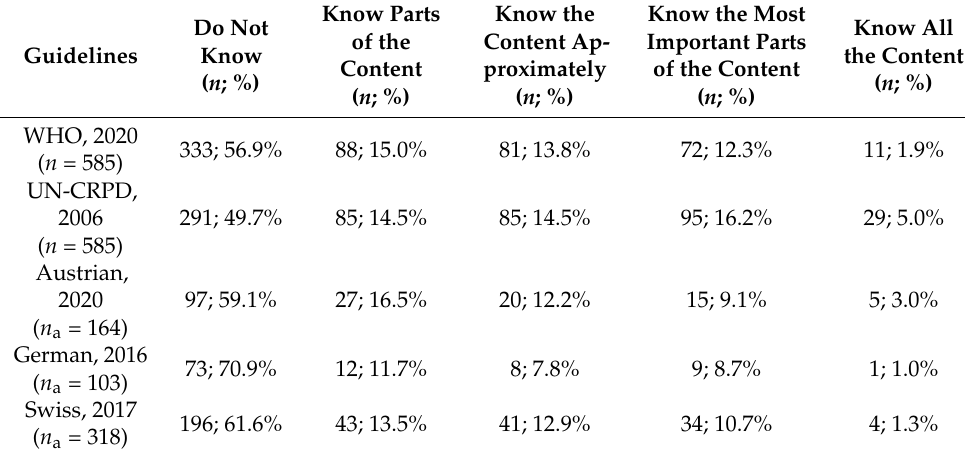
Table 2. Frequency of self-reported knowledge of the specific